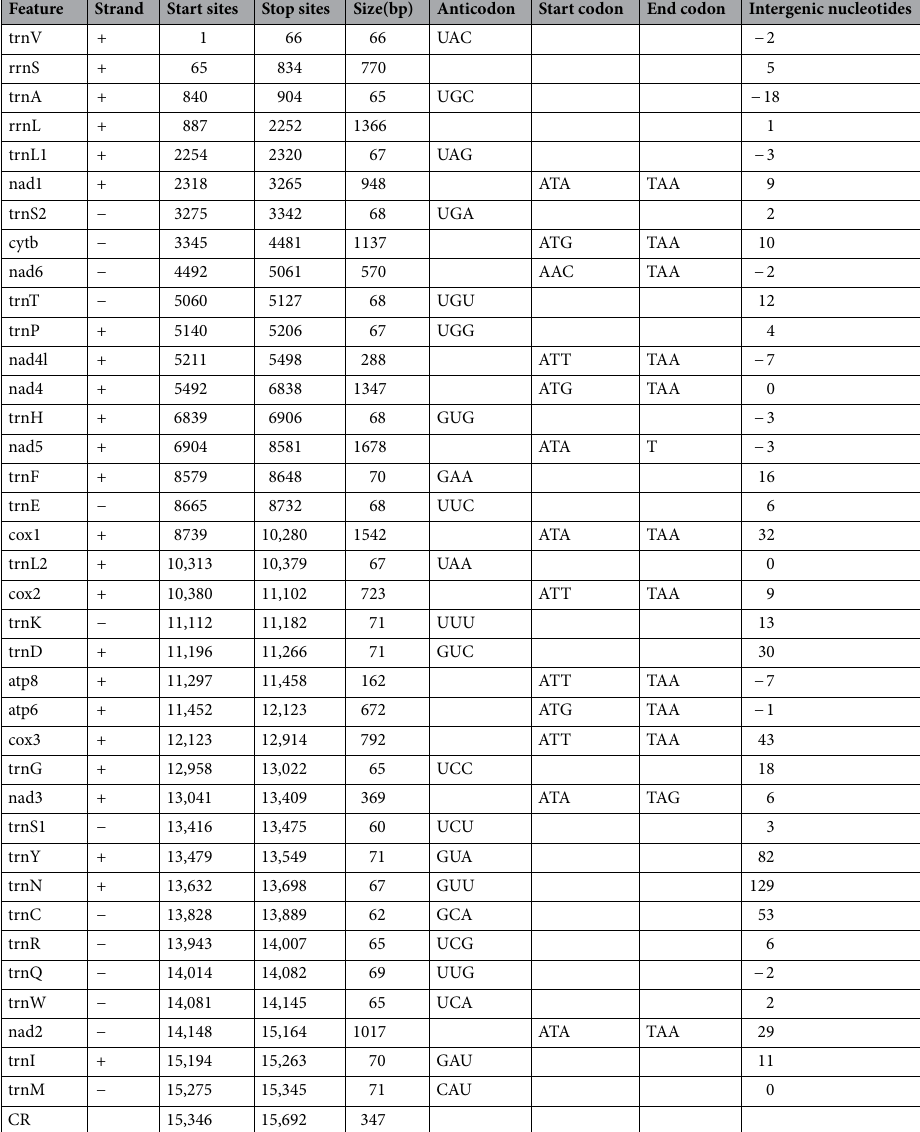
Table 1. Characteristics of the mitochondrial genome of A. fulloi . + represents the heavy strand; − represents the light